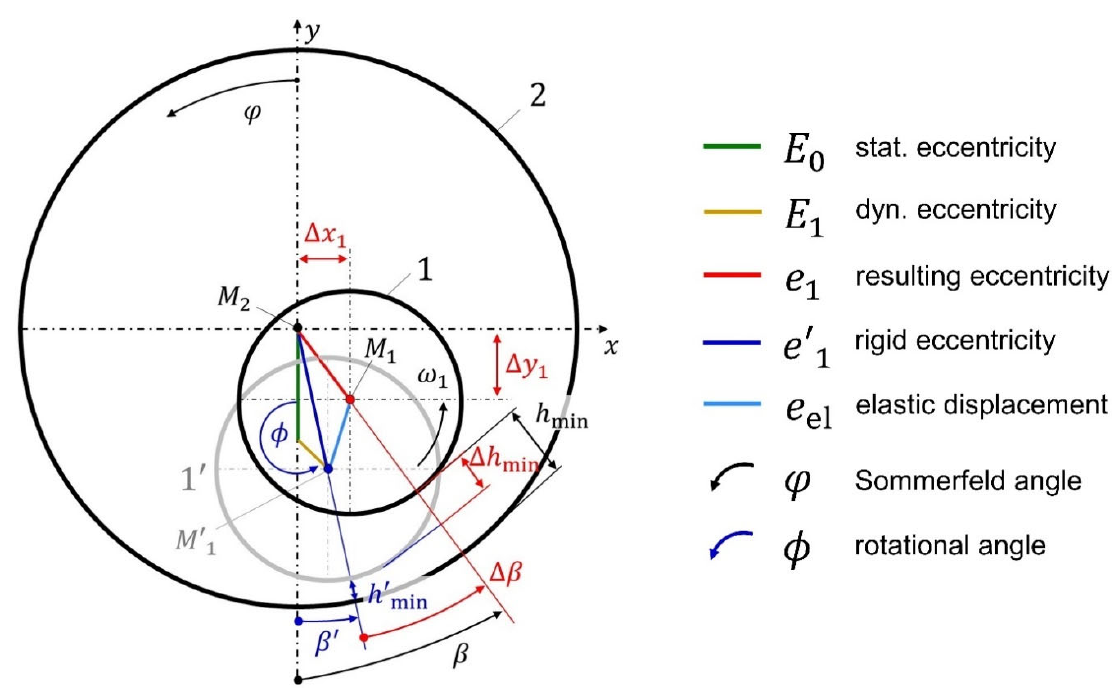
Figure 3. Main parameters of experiment and Couette